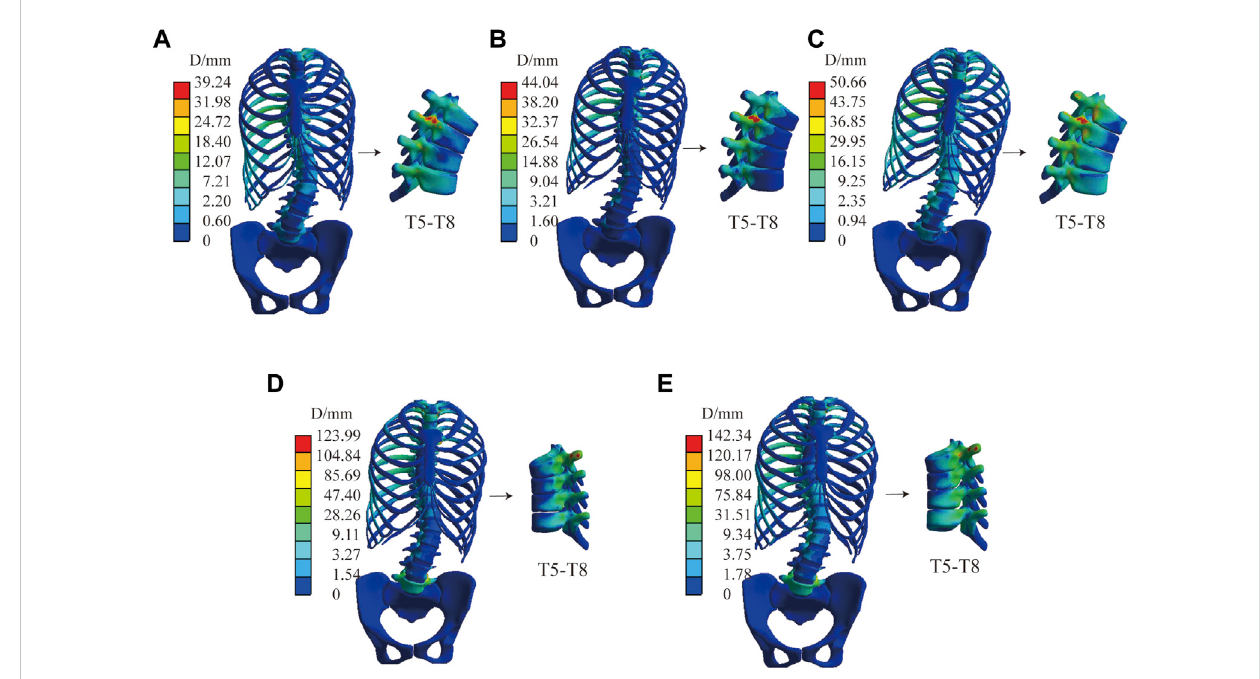
The displacement distribution of normal spine under C5. (A) Finiteelementmodelwithligaments. (B) Finiteelementmodelwithout